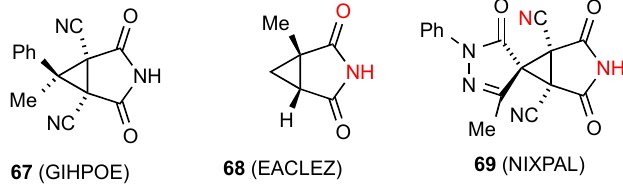
Figure 24. Structures of succinimides fused to three-membered rings.